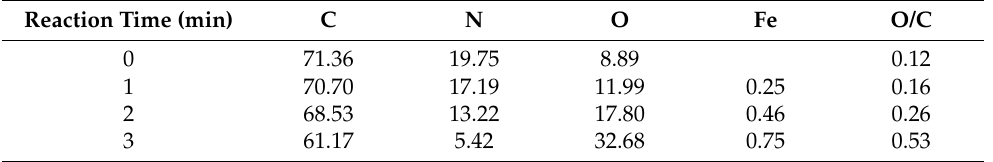
Table 2. Surface elemental composition of the membranes from XPS analysis. Reaction Time (min)